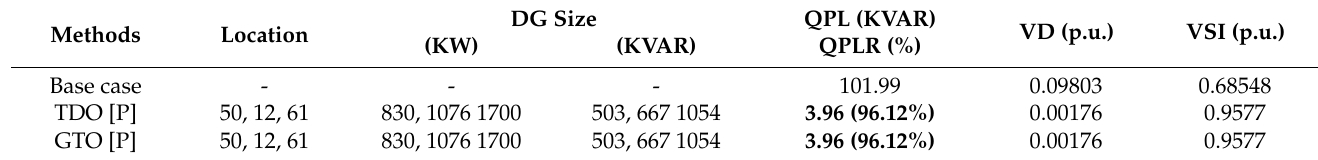
Table A6. Results of OADG for a 69-bus RDN for QPL minimization at 0.85 pf (WT type) with a CP load